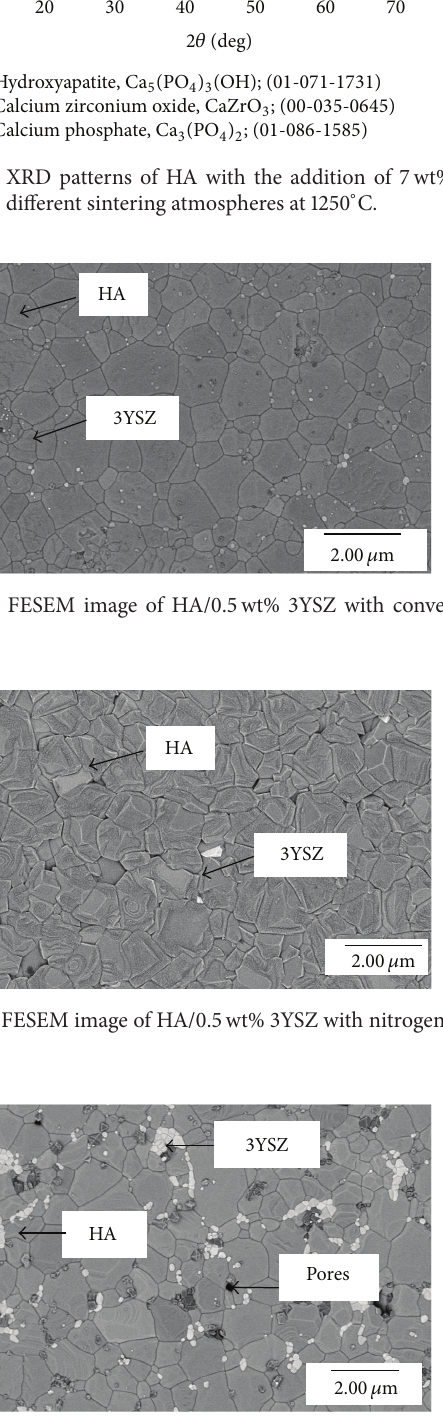
Figure 8: FESEM image of HA/7 wt% 3YSZ with nitrogen sintering.